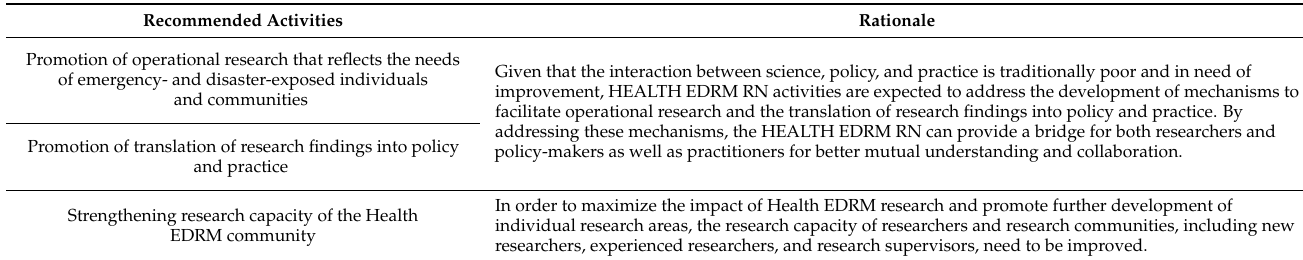
Table 1. Recommendations for HEALTH EDRM RN activities to ensure their success and effectiveness